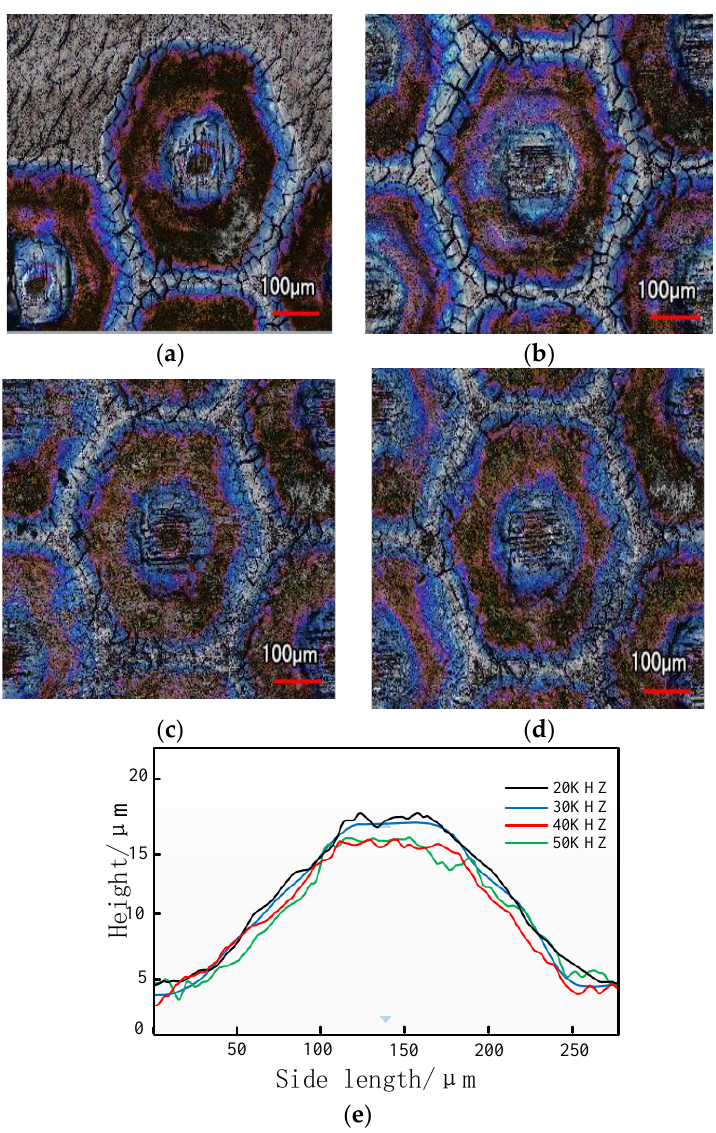
Figure 11. The relationship between machining frequency and the appearance of the surface. ( a ) f = 20 kHZ, ( b ) f = 30 kHZ, ( c ) f = 40 kHZ, ( d ) f = 50 kHZ, ( e ) Contour graph for different frequency.